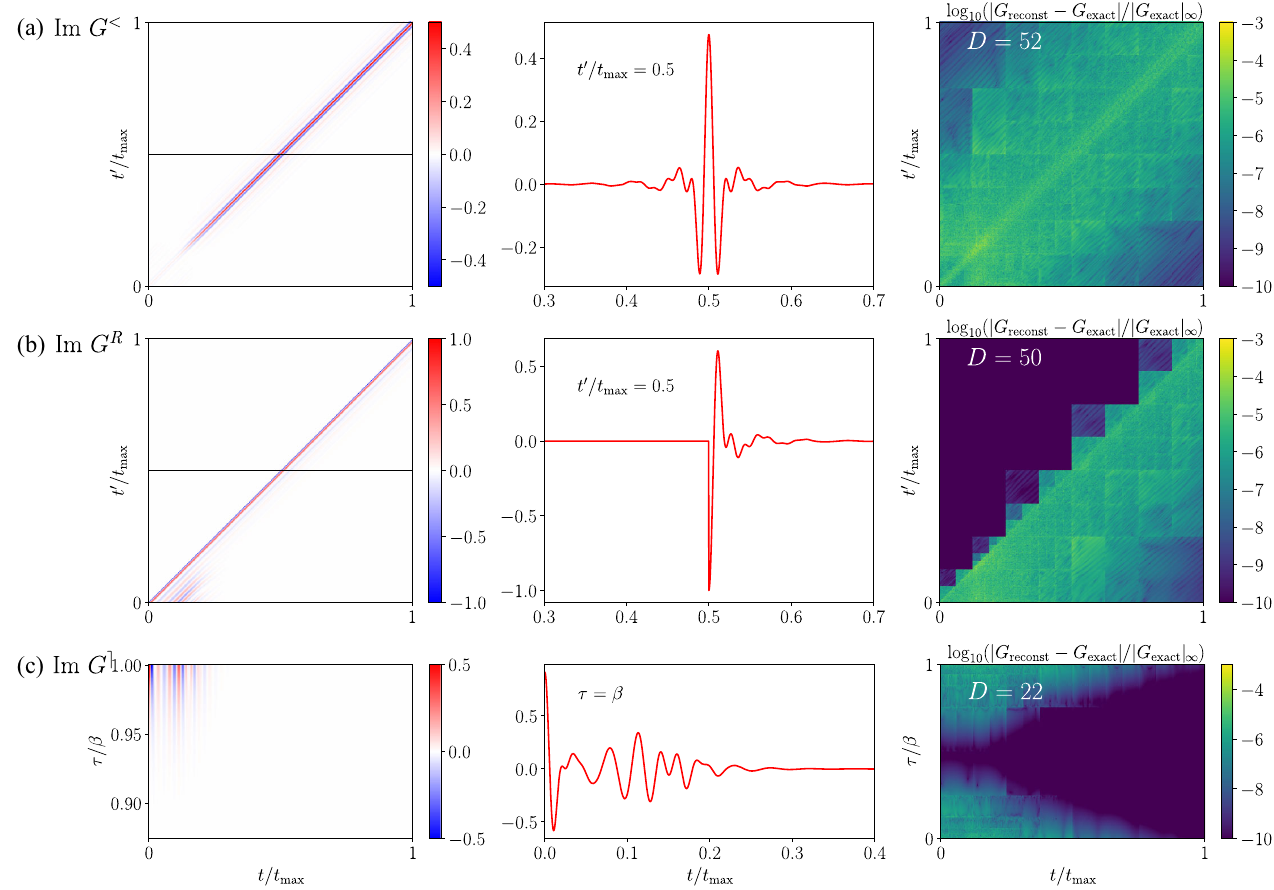
FIG. 20. Nonequilibrium Green ’ s functions computed for the photoexcited antiferromagnetic system. See the caption of Fig. 19 for the description of the panels.